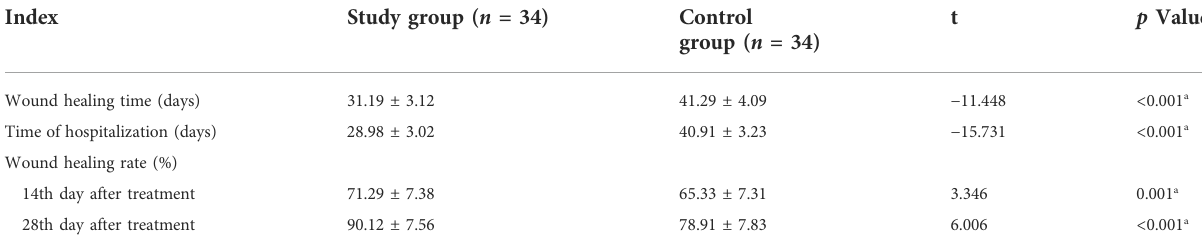
TABLE 2 Comparison of wound healing time, hospital stay and wound healing rate between two groups.(Mean ± Standard Deviation). Index Study group ( n = 34)